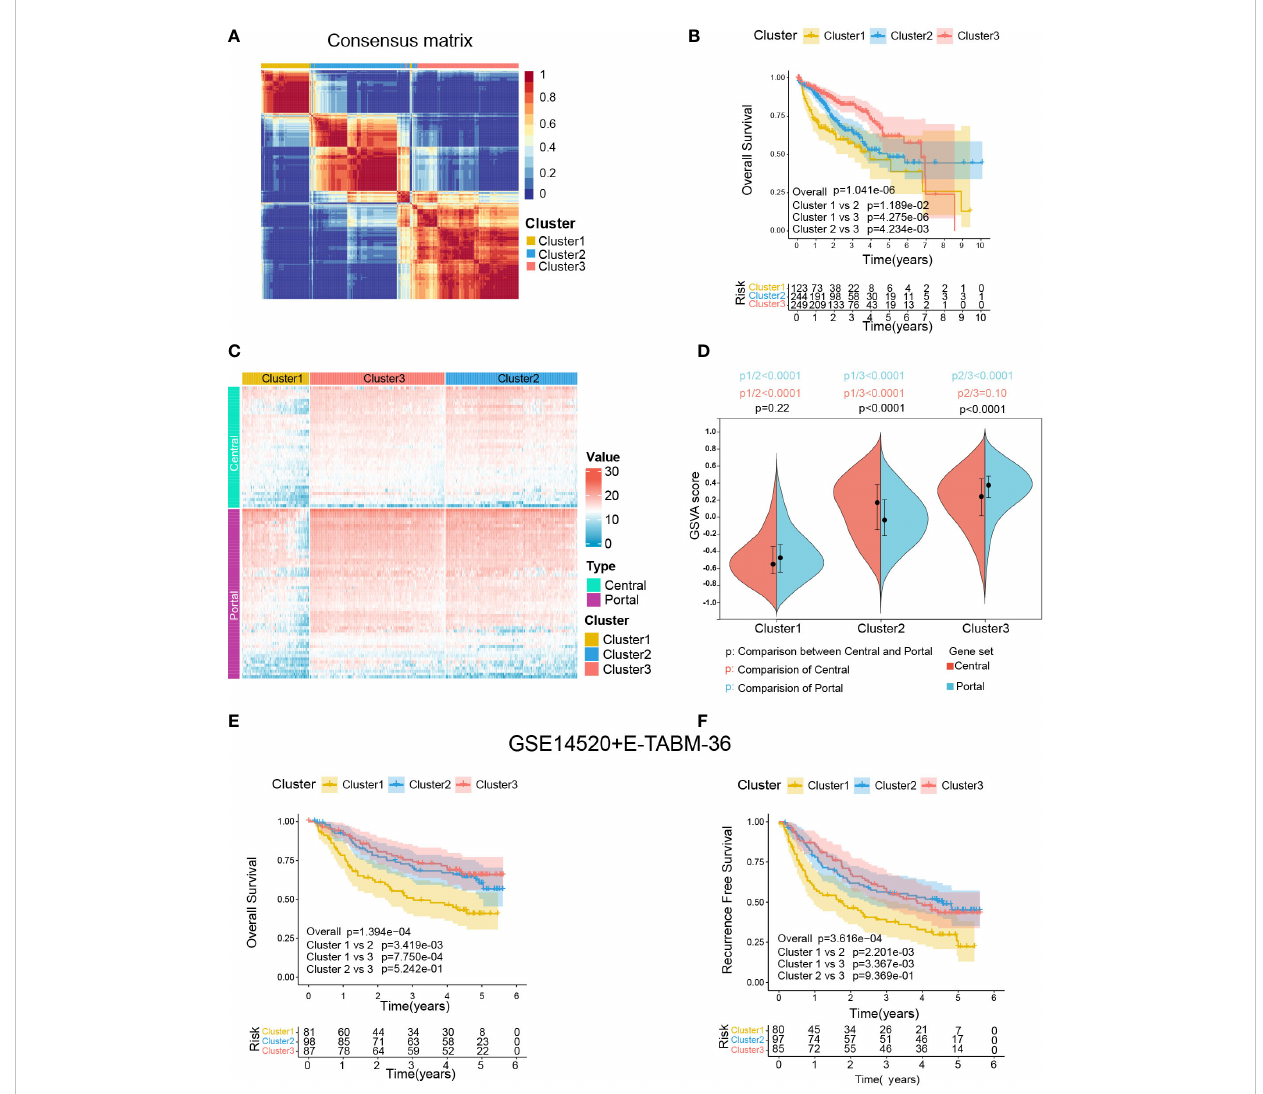
FIGURE 3 Identi fi cation of zonation marker-associated HCC subclasses using NMF clustering. (A) Heatmap plot shows the consensus matrix of NMF clustering results using the gene expression data of 94 zonation markers in the RNA-seq cohort (TCGA-LIHC+ICGC-LIRI-JP), colored by three HCC subclasses (Cluster1, Cluster2, and Cluster3). (B) Kaplan-Meier survival analysis of OS of the three clusters. (C) Heatmap plot shows the expression pattern of the zonation markers of the three clusters. (D) The difference of the GSVA scores of the portal and central signatures among the three clusters. Comparison between central and portal by Student ’ s t-test; Comparison among three clusters by ANOVA -Tukey test. (E, F) Kaplan-Meier survival analysis of OS and RFS of the three clusters from in microarray cohort (GSE14520+E-TABM-36). OS, Overall survival; RFS, Recurrence-free survival; GSVA, Gene set variation